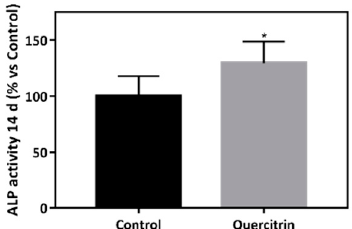
Figure 6. Implant bioactivity under bacterial challenging conditions. Alkaline phosphatase activity in MC3T3-E1 cells treated with 1µg/mL E. coli LPS (lipopolysaccharide) for 72 h seeded onto coin and 3D implants at 14 of cell culture ( n = 6). Values represent mean (SD). Results were statistically compared by Student’s t -test: * p < 0.05 vs. Control.